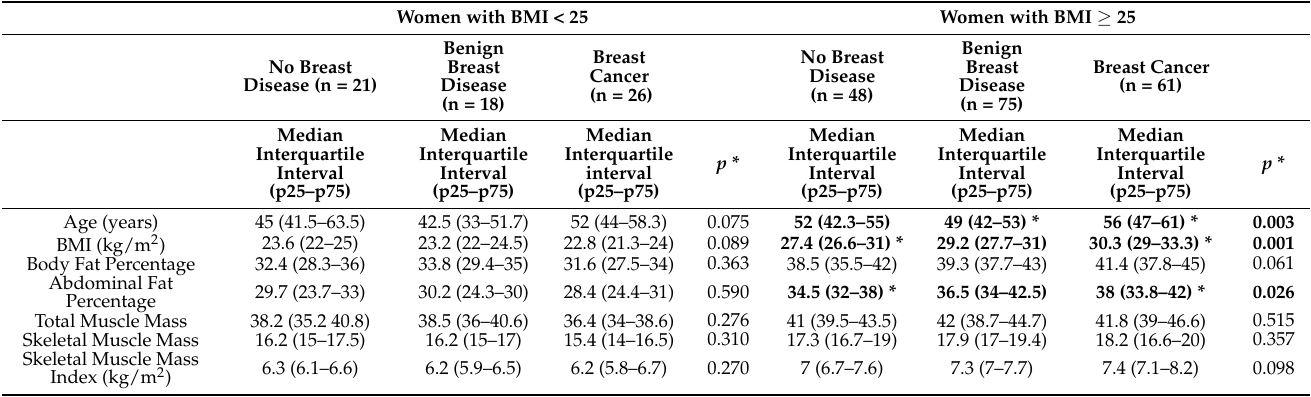
Table 2. Anthropometric indicators in a group of over-40-year-old Mexican women undergoing mastographic